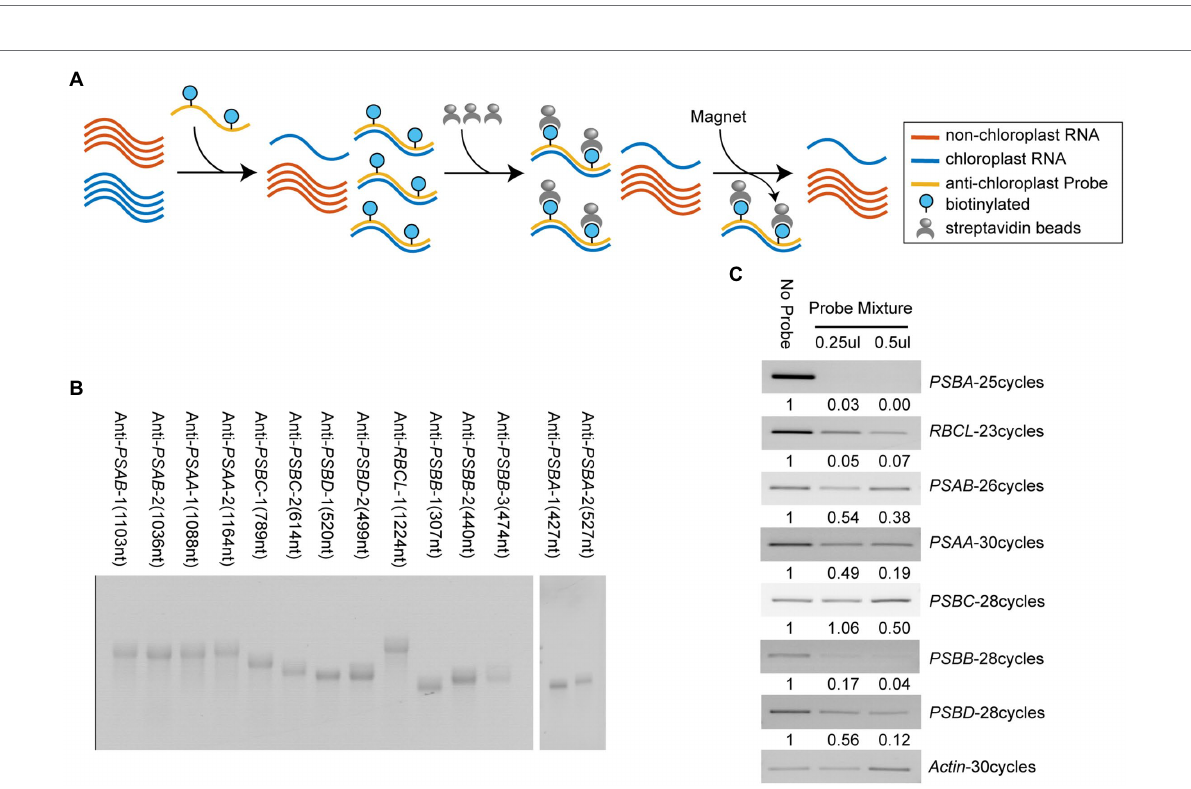
FIGURE 4 | Specific depletion of highly-expressed chloroplast transcripts. (A) Workflow of the streptavidin-biotin depletion approach for reducing abundance of highly-expressed chloroplast RNAs. (B) Images of denatured gel electrophoresis showed home-made biotinylated RNA probes were high purity. (C) RT-PCR results showed efficient depletion of specific chloroplast transcripts using antisense biotinylated RNA